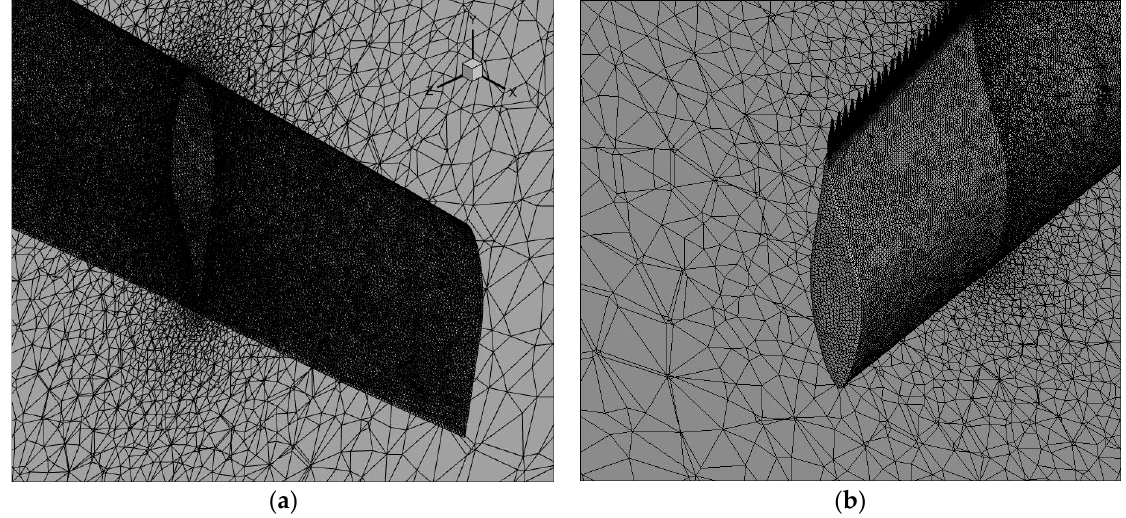
Figure 5. Close ‐ up of the mesh topology on the ( a ) clean blade and the ( b ) modified blade . Figure 5. Close-up of the mesh topology on the ( a ) clean blade and the ( b ) modified blade. Table 6. Details of grid topology used are used for the clean and the modified blades. Table 7. Grid independence of an unstructured mesh. Clean Blade: At 7